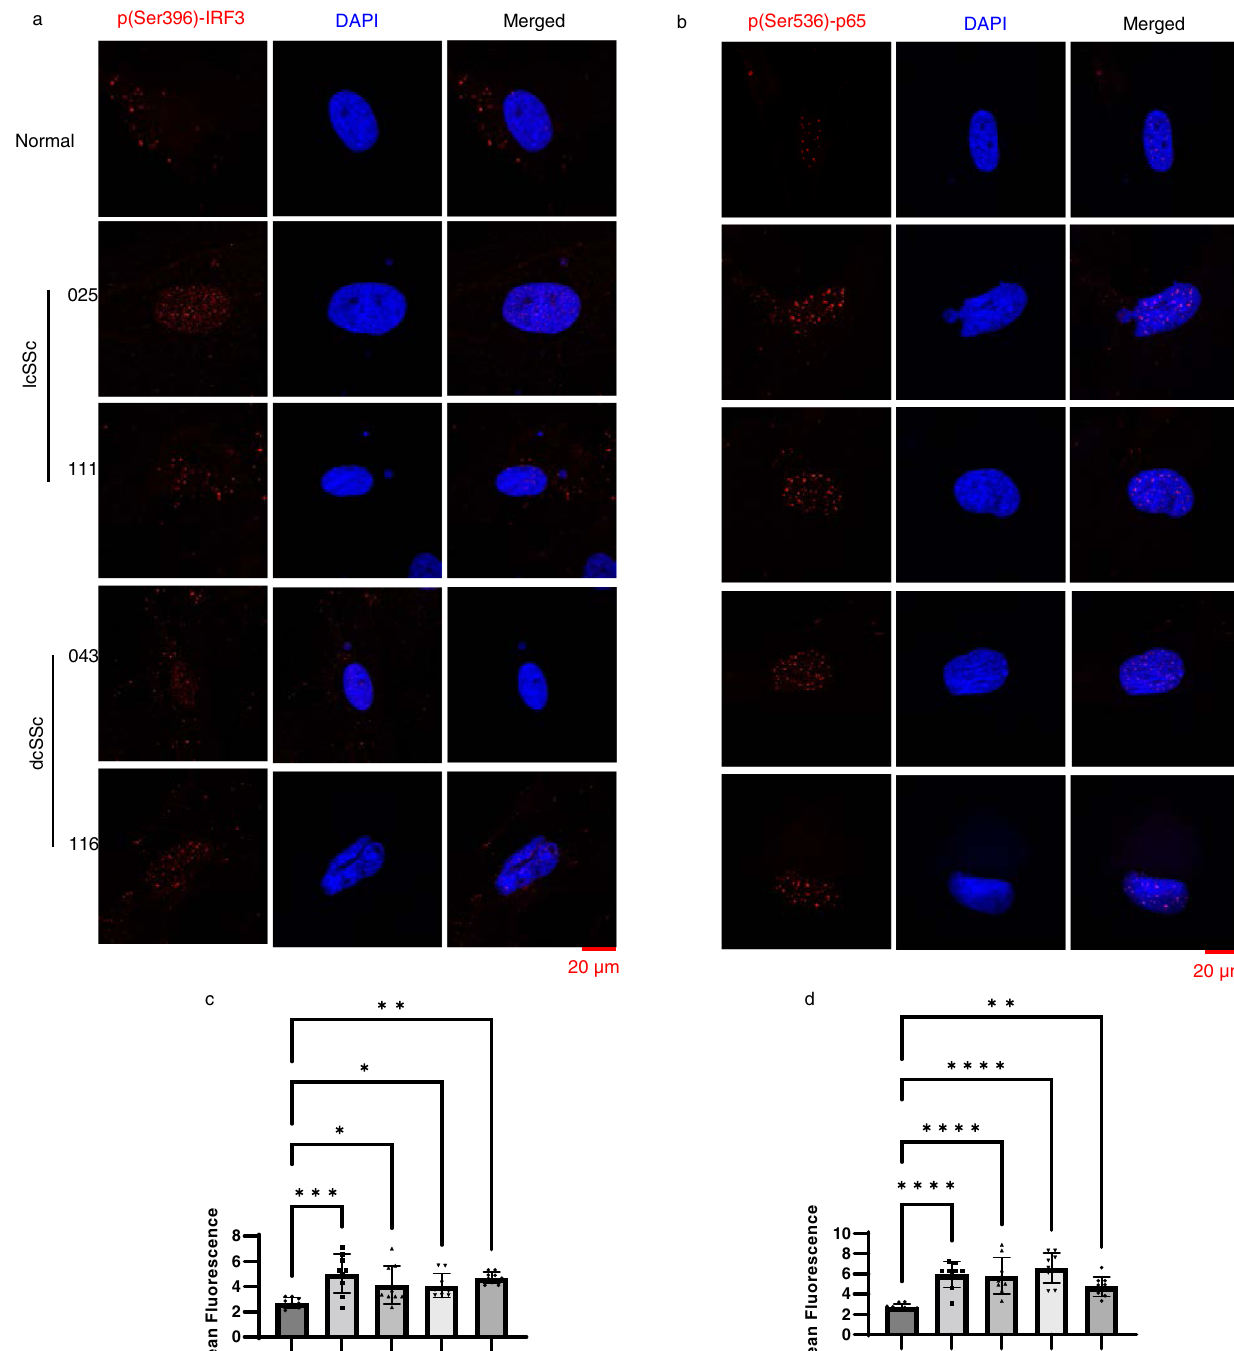
Fig. 7 | Expression of IRF3 and p65 in SSc skin fi broblasts. IF showing the expression cGAS-STING downstream factors (red) Phospho-IRF3 ( a ) and Phospho p65(RELA)( b )inSScskin fi broblasts.NucleiwerecounterstainedwithDAPI(blue). IRF3 and p65 are phosphorylated at serine residues following cGAS-STING activa- tion.PhosphorylatedIRF3formsadimerandtranslocatestothenucleustoactivate IFN- β andothercytokines.P65(RELA)translocatestothenucleusaftercGAS-STING activation. Both proteins activate the IFN- β pathway. The scale bar is shown at the bottomright.The bargraphs( c – d )showthemean fl uorescencelevelof respective